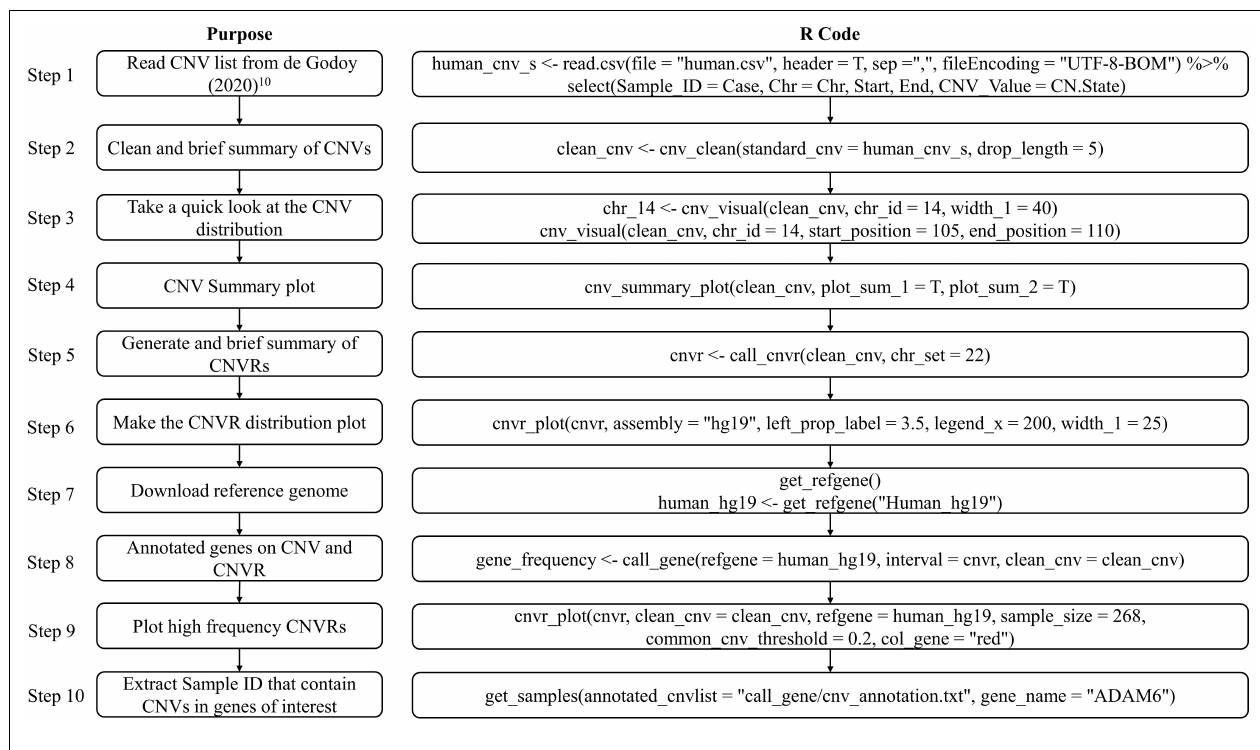
FIGURE 4 | Analytical steps of example